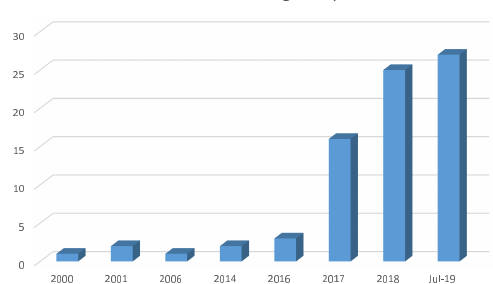
Fig. 1: Statistics of published studies on the 3-D human pose estimation following each